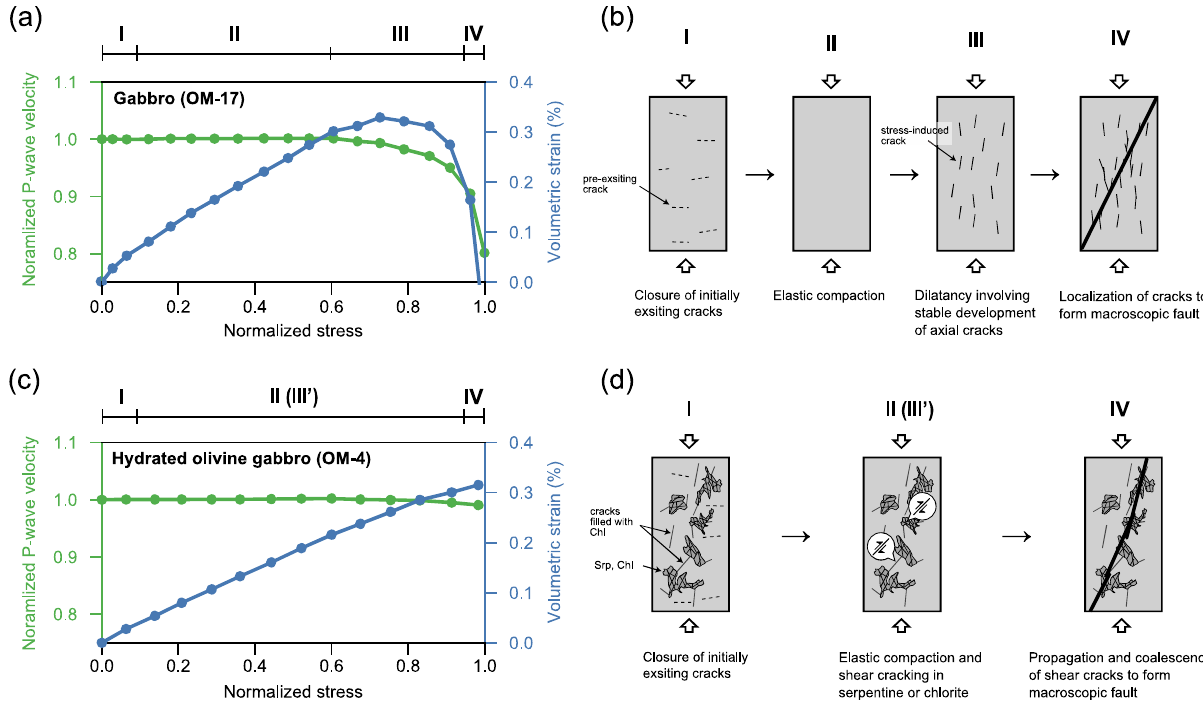
Figure 9. Ultrasonic and mechanical data with schematic diagrams showing the stages of brittle deformation for gabbro (OM-17) and hydrated olivine gabbro samples (OM-4). Normalized P-wave velocity and volumetric strain estimated from calculated crack density, assuming the aspect ratio to be 0.01, are plotted against normalized differential stress ( a , c ). Schematic models of the brittle deformation mechanisms in gabbro and hydrated olivine gabbro ( b , d ). The onset of each stage of deformation in relation to the ultrasonic and mechanical data is shown at the top of ( a , c ), respectively.